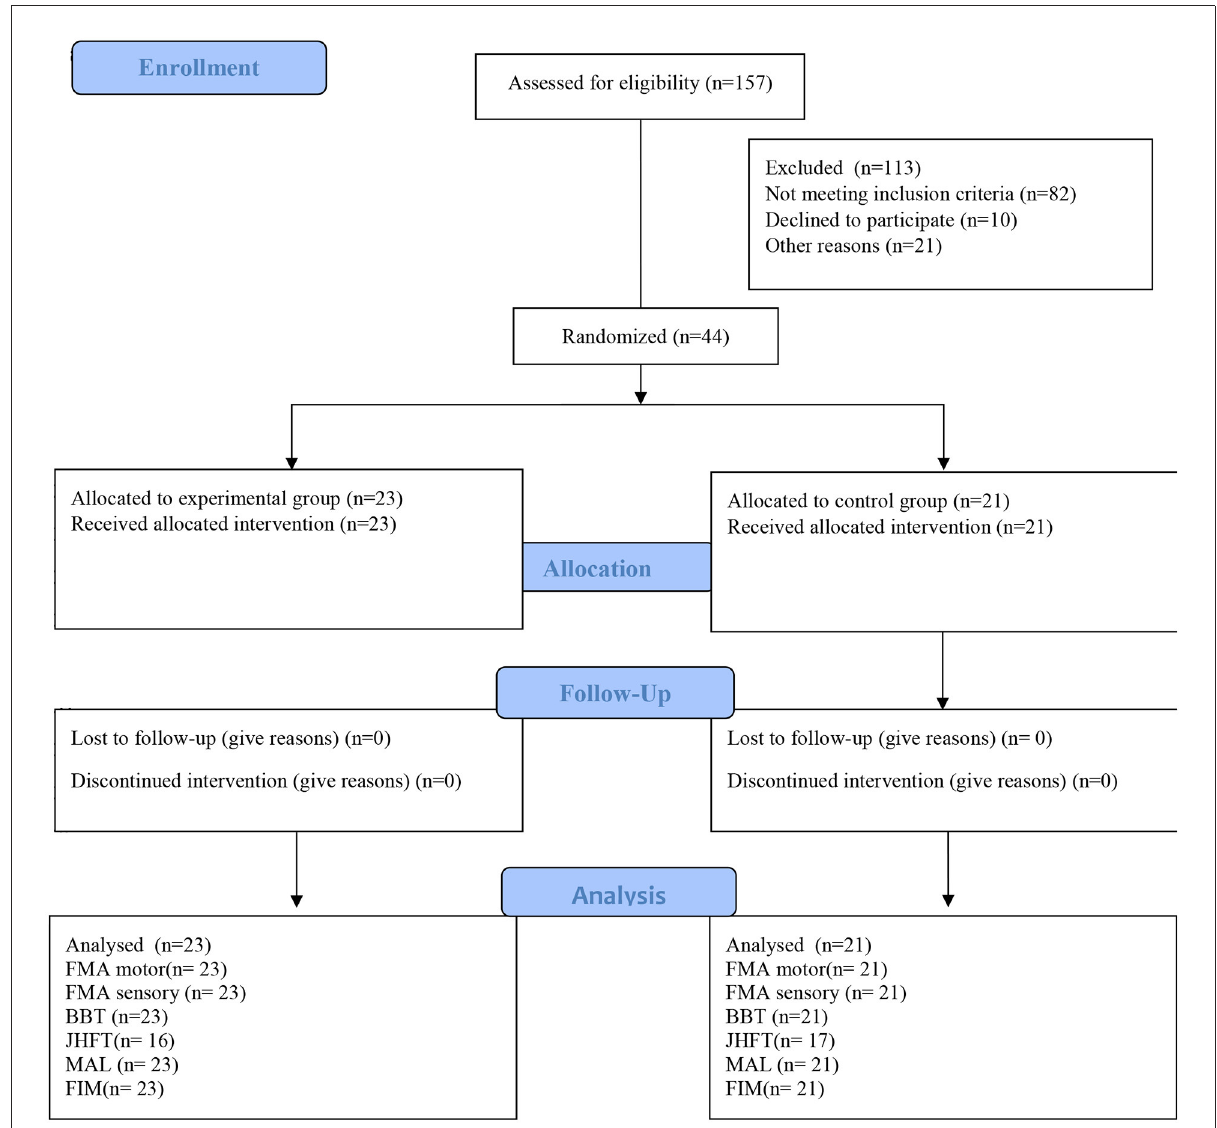
FIGURE2 CONSORT flow diagram. FMA, motor, upper limb Fugl-Meyer for motor function; FMA, sensory, upper limb Fugl-Meyer assessment for sensory function; BBT, box and block test; FIM, functional independence measure; JHFT, Jebsen hand function test; MAL, motor activity long test.